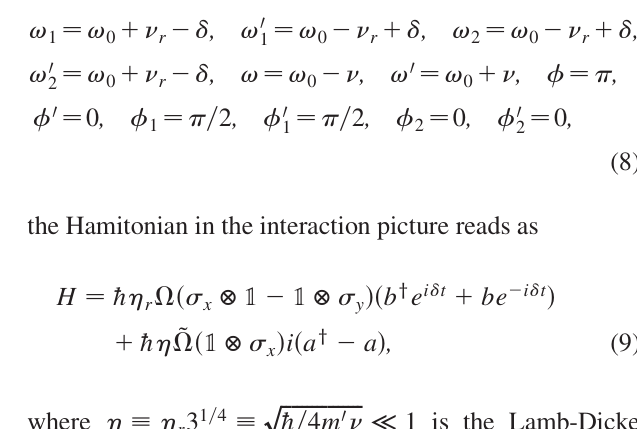
FIG. 1. Diagram showing the different steps involved in the proposed quantum simulation of unphysical operations in 1 þ 1